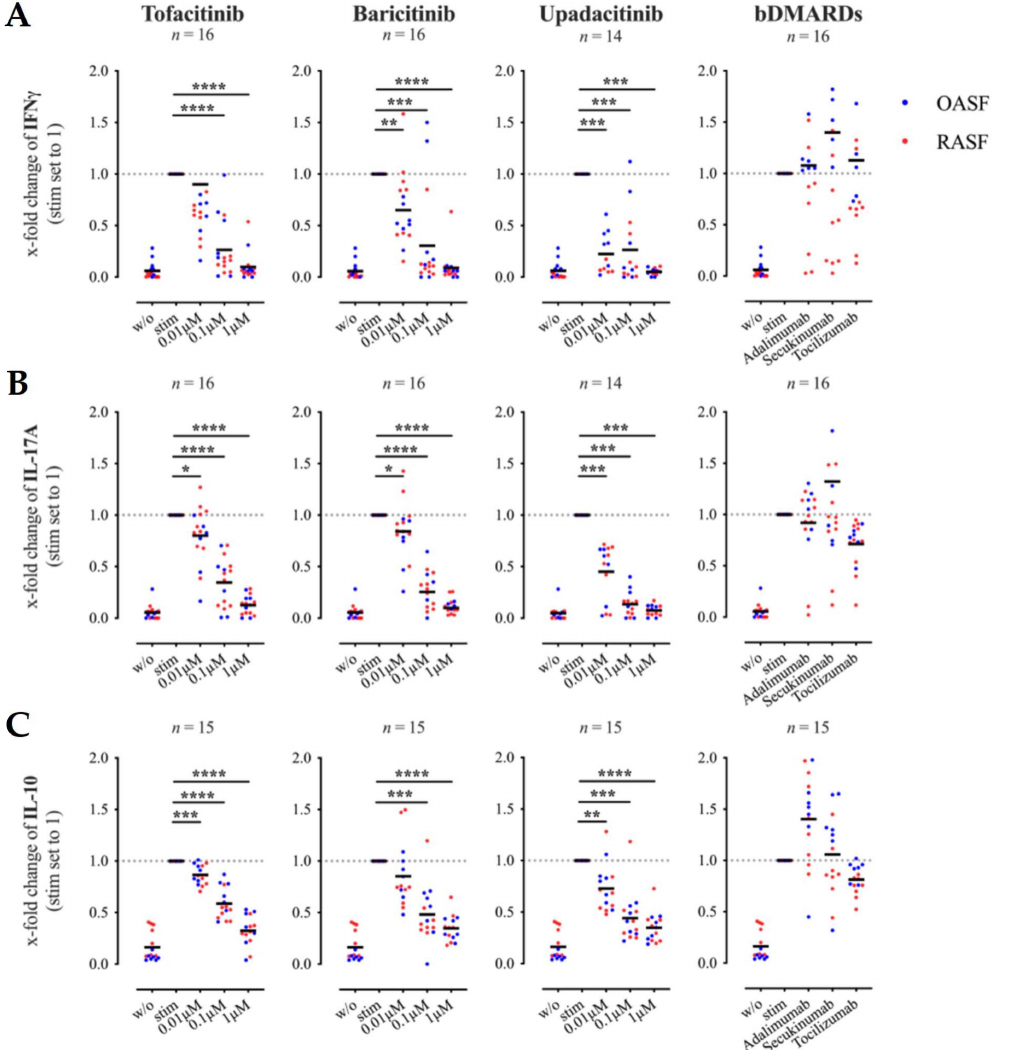
Figure 2. Effects of tofacitinib, baricitinib, upadacitinib and bDMARDs on interferon (IFN) γ ( A ), IL-17A ( B ) and IL-10 ( C ) secretion in Th cell-SF co-cultures. RASF (red) or OASF (blue) were co-cultured with Th cells (ratio 1:5) in the presence or absence of anti-CD3/ anti-CD28 antibodies and drugs as indicated. Results are presented as x-fold change with stimulated SF-Th cells set to 1 (mean concentrations ± SEM in co-cultures of SF with stimulated Th cells (in pg/mL): IFN γ : 452.06 ± 137.67; IL-17A: 6772.01 ± 1689.89; IL-10: 2140.26 ± 185.16). Supernatants were collected on day 6 and cytokine concentrations were quantified by ELISA. Data shown as grand mean, significance tested using Wilcoxon signed-rank test, p **** ≤ 0.0001, p *** ≤ 0.001, p ** ≤ 0.01, p * ≤